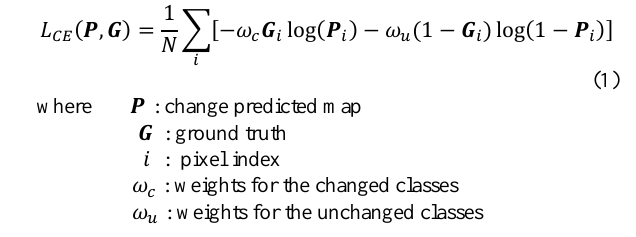
denotes the combination of 1,2